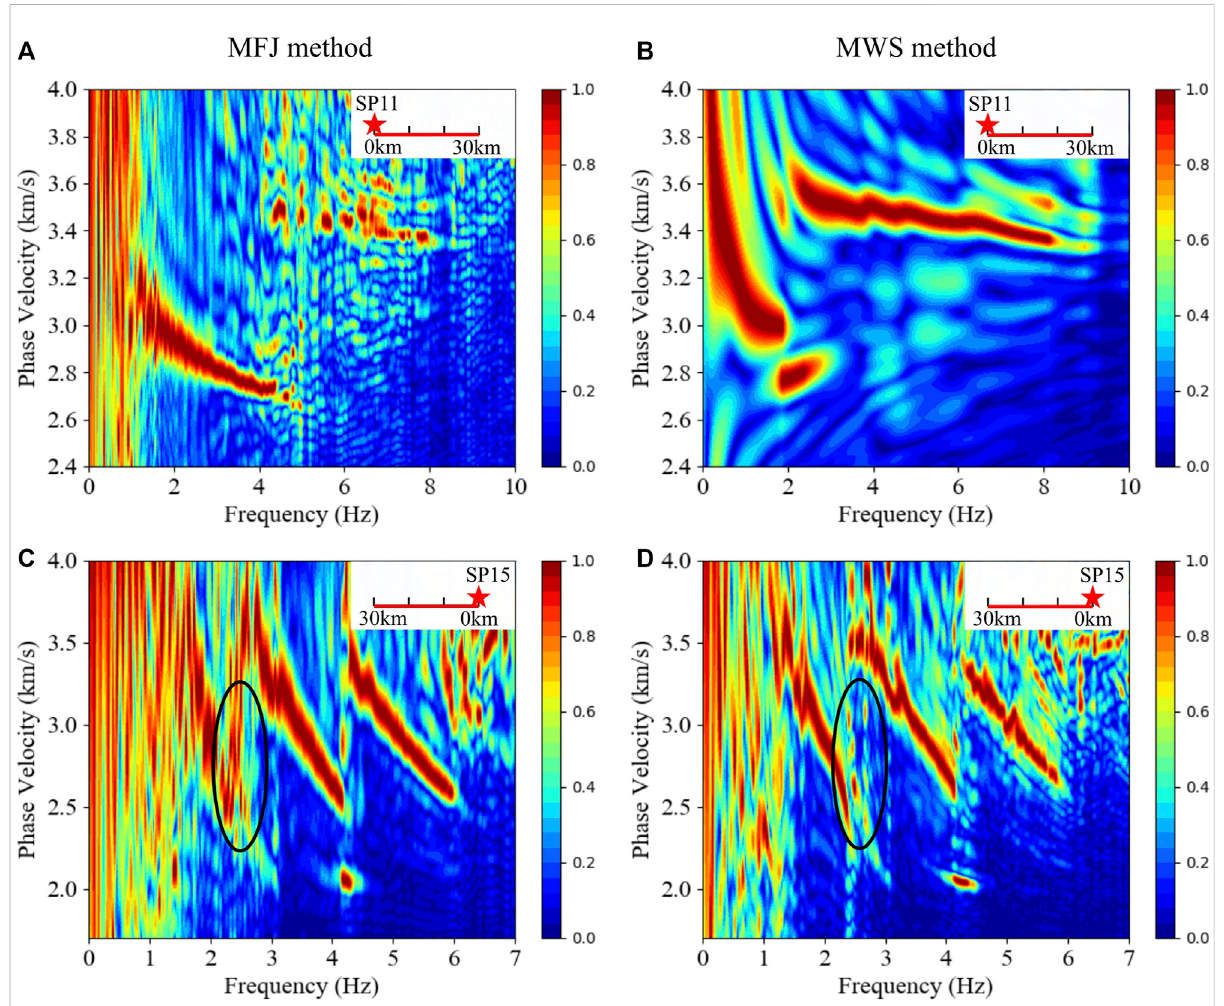
FIGURE 3 F – J spectrograms extracted from 30-km-long seismic record sections. In the upper right corner of each fi gure, the red star represents the source,andtheF-Jspectrogramisextractedfromtheseismicdataontheredline. (A) and (B) arethespectrogramsextractedfromtheSP11datawith the MFJ method and MWS method, respectively. (C) and (D) are the spectrograms extracted from the SP15 data with the MFJ method and MWS method,